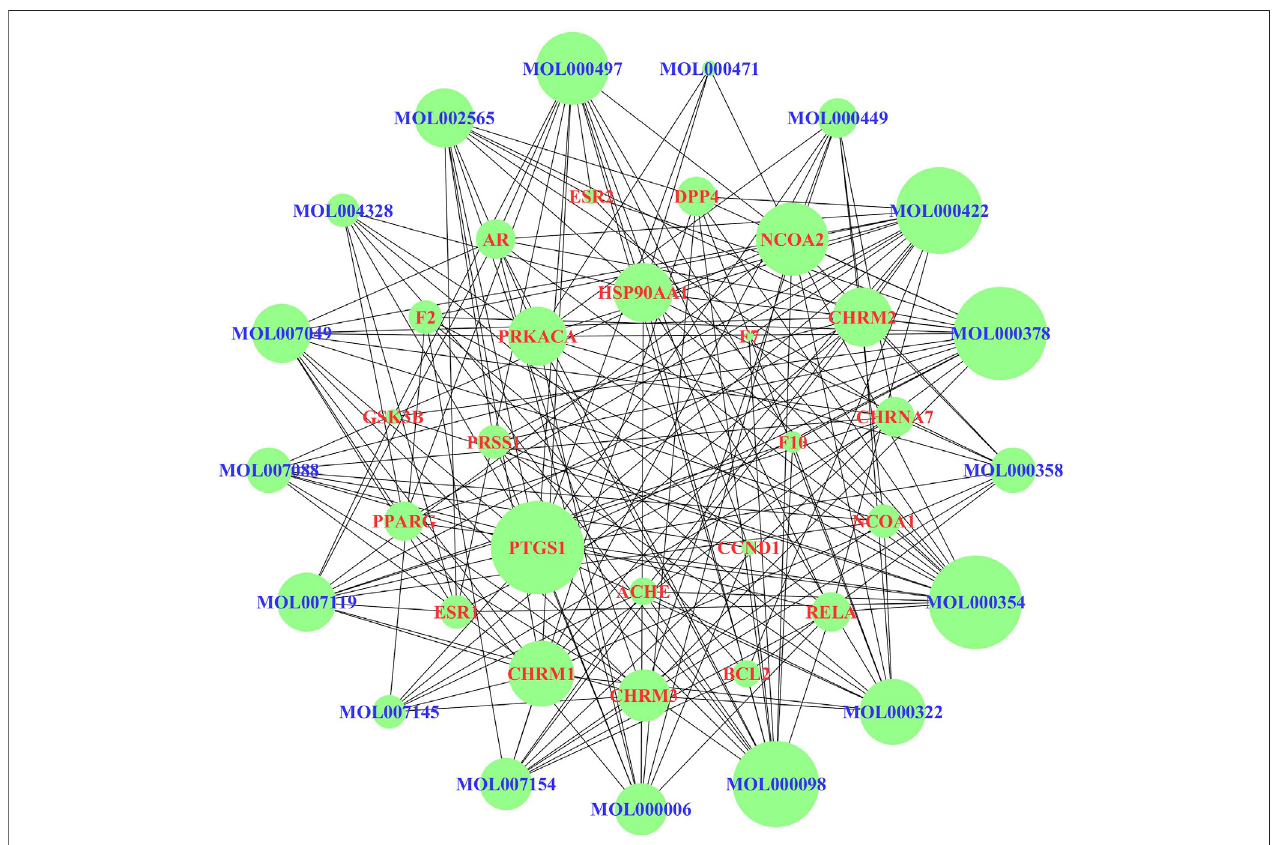
FIGURE 5 | The core targets and compounds in the “ chemicals-shared target genes-signal pathway ” (C-T-S) network. The nodes with a larger area have a larger degree value.